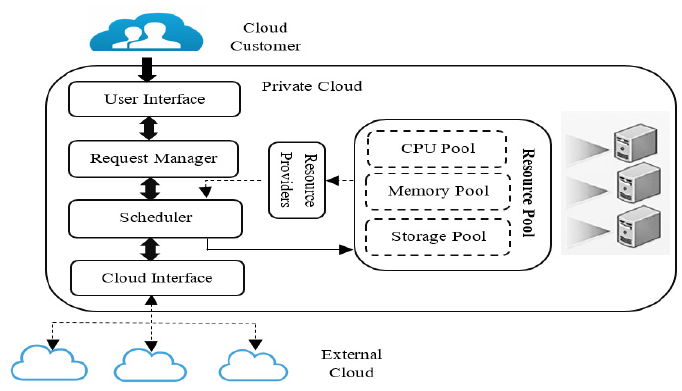
Figure 1. Proposed system model with private and external